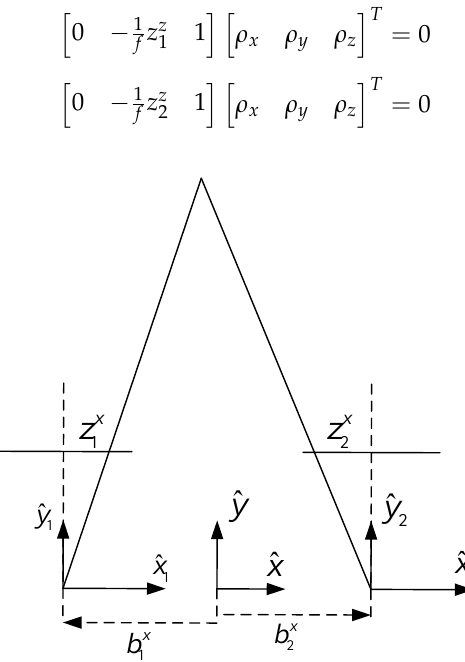
Figure 2. A two dimensional geometry of two aligned cameras and a point’s projection on their respective image